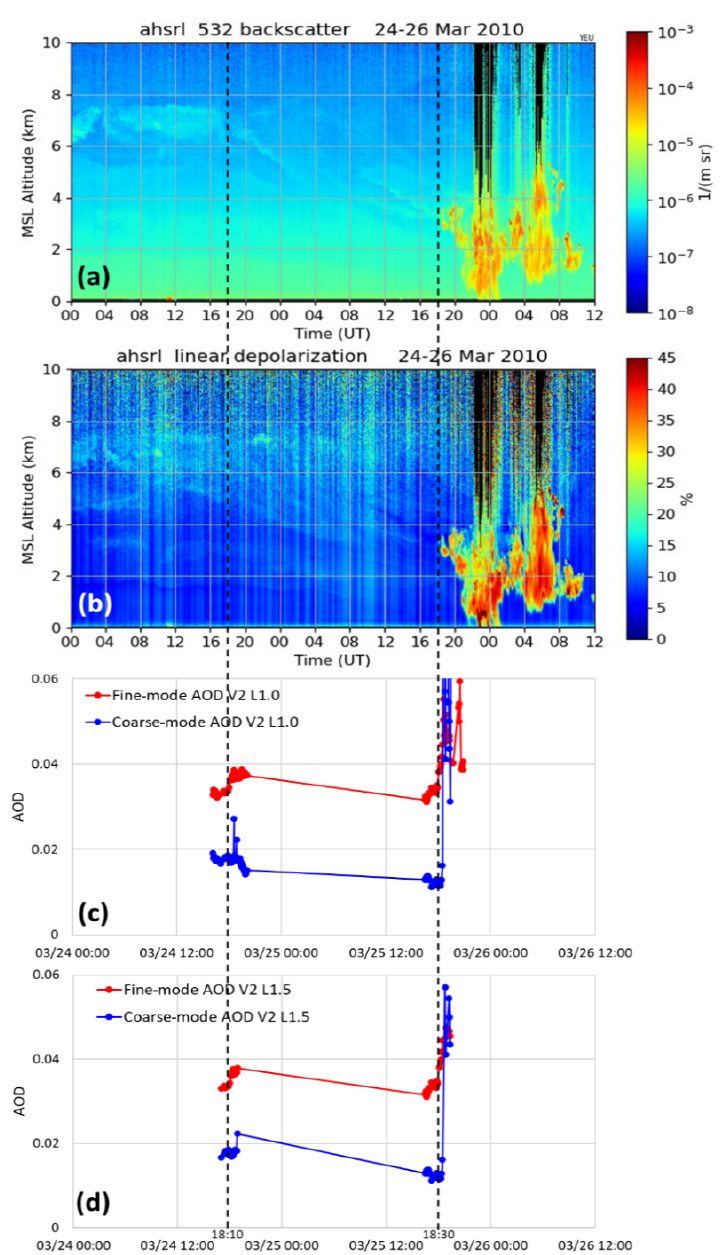
Figure 1. (a) AHSRL backscatter coefficient ( β ) profile. (b) AHSRL linear depolarization ( δ ) profile. (c) Level-1.0 (non-cloud-screened) fine-mode and coarse-mode AODs. (d) Level-1.5 (cloud-screened) fine-mode and coarse-mode AODs (a standard AERONET product). All times are UT. The 24 March, 18:10 dashed vertical line indicates the beginning of the decrease in thickness of the coarse-mode plume seen in the weak β profile and the moderate δ profile with an attendant weak decrease in the coarse-mode AOD (decrease ∼ 0.005 from approximately 0.02 to 0.015 for the Version 2 Level-1.0 coarse-mode AOD retrievals). The same decrease (but for different individual magnitudes of ∼ 0.01 to 0.005) are obtained using Version 3 Level-1.0 retrievals (which were unavailable when the authors wrote their paper). The 25 March, 18:30 dashed vertical line indicates the beginning of the rapid increase in the coarse-mode AOD due to what is very likely cloud associated with the sharp increases in the β and δ profiles (cloud presence is typically associated with high-frequency (rapid) coarse-mode AOD increases). It should be emphasized that the V2 Level-1.5 (cloud-screened) retrievals did not succeed in eliminating certain high-frequency coarse-mode AOD variations near the rapid rise at 18:30. V3 Level-1.5 retrievals did eliminate the coarse-mode AOD in the region of that rapid rise (but failed to eliminate some thinner cloud of relatively low coarse-mode AOD a few hours